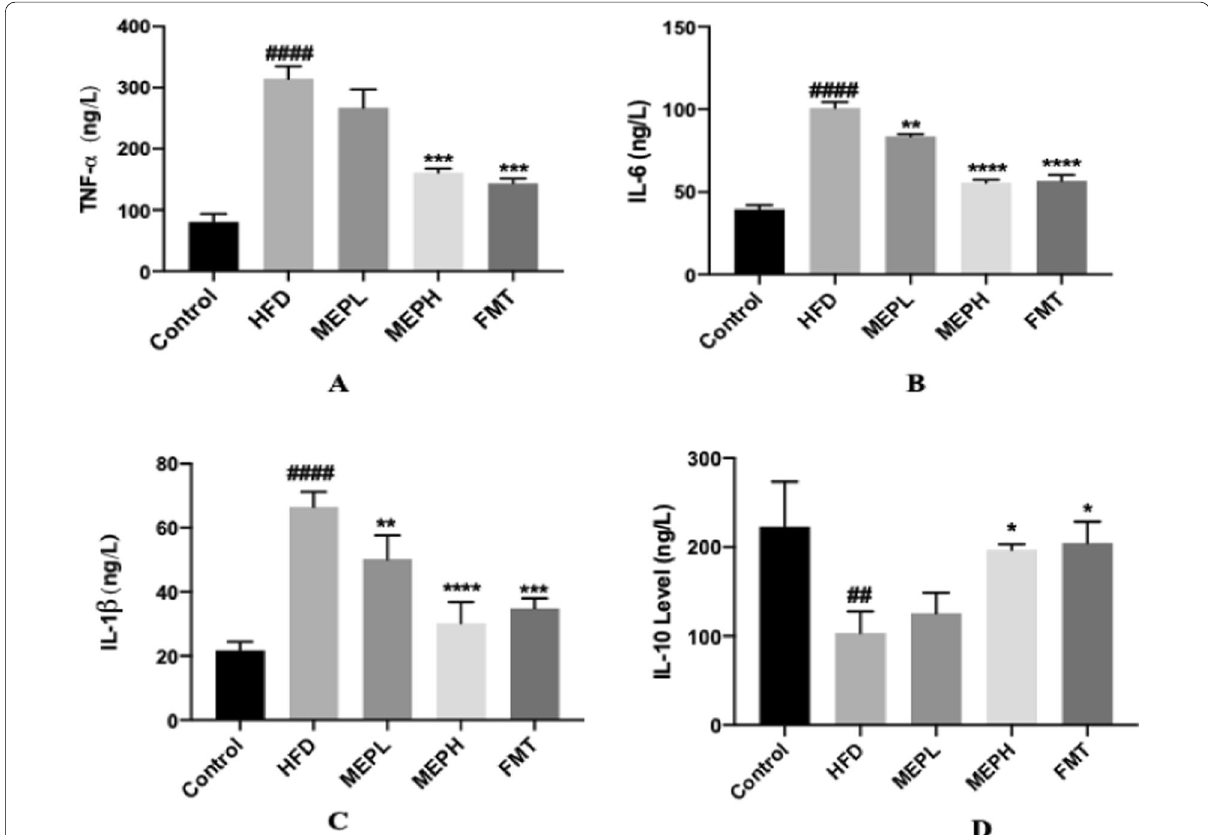
Fig. 7 Effect of MEP on inflammatory cytokines in HFD-induced obese mice. A–C Pro-inflammatory cytokine levels of TNF-α, IL-6 and IL-1β. D The levels of anti-inflammatory cytokines and IL-10 levels in serum were determined by ELISA kits. The data was obtained by three independent experiments and is expressed as mean SEM (n 4). Significant differences were shown using at # p < 0.05, ## p < 0.01, ### p < 0.001 and #### p < 0.0001 ± = vs. Control group and *p < 0.05, **p < 0.01, ***p < 0.001 and ****p < 0.0001 vs. HFD